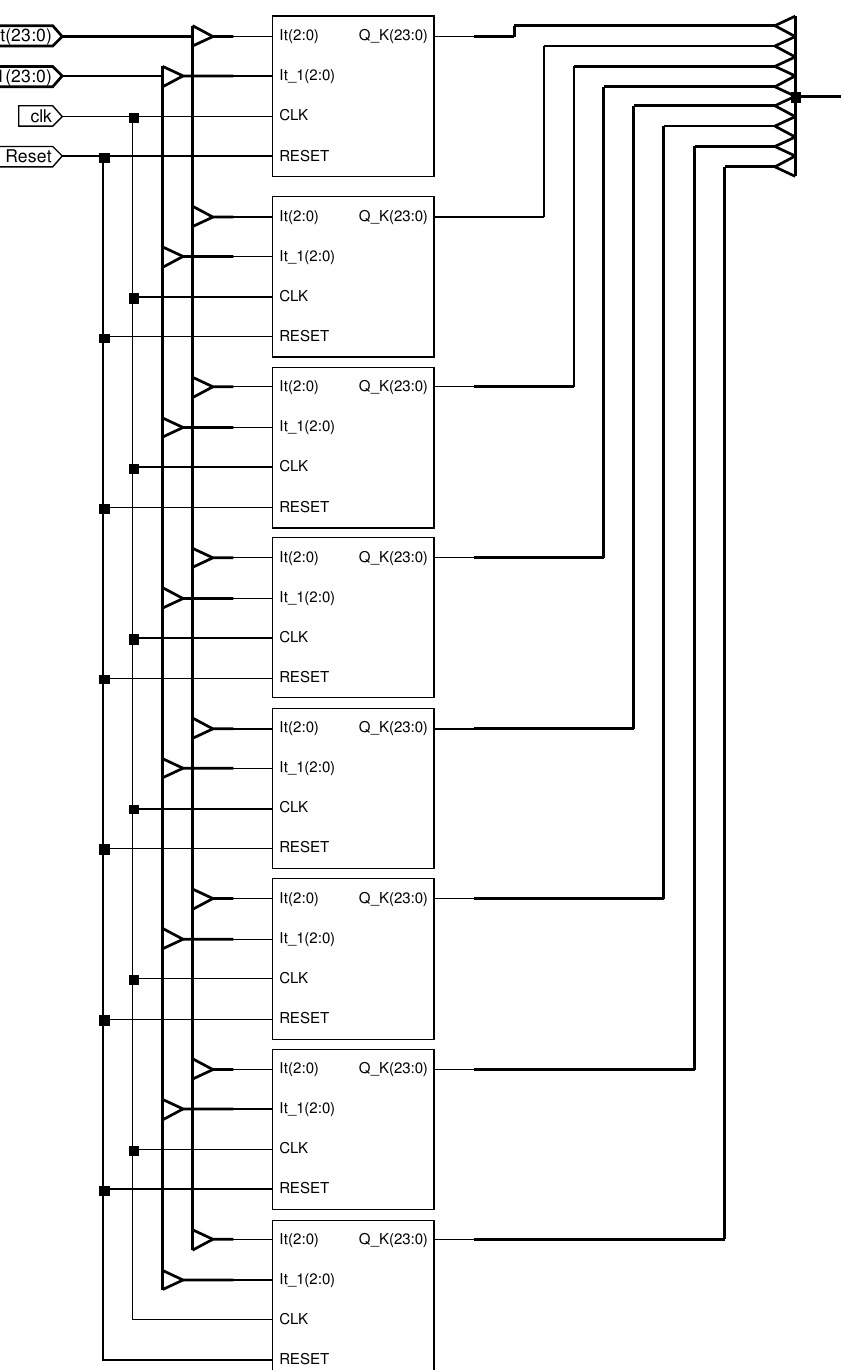
Figure 5. Layout of an 8 -AC motion